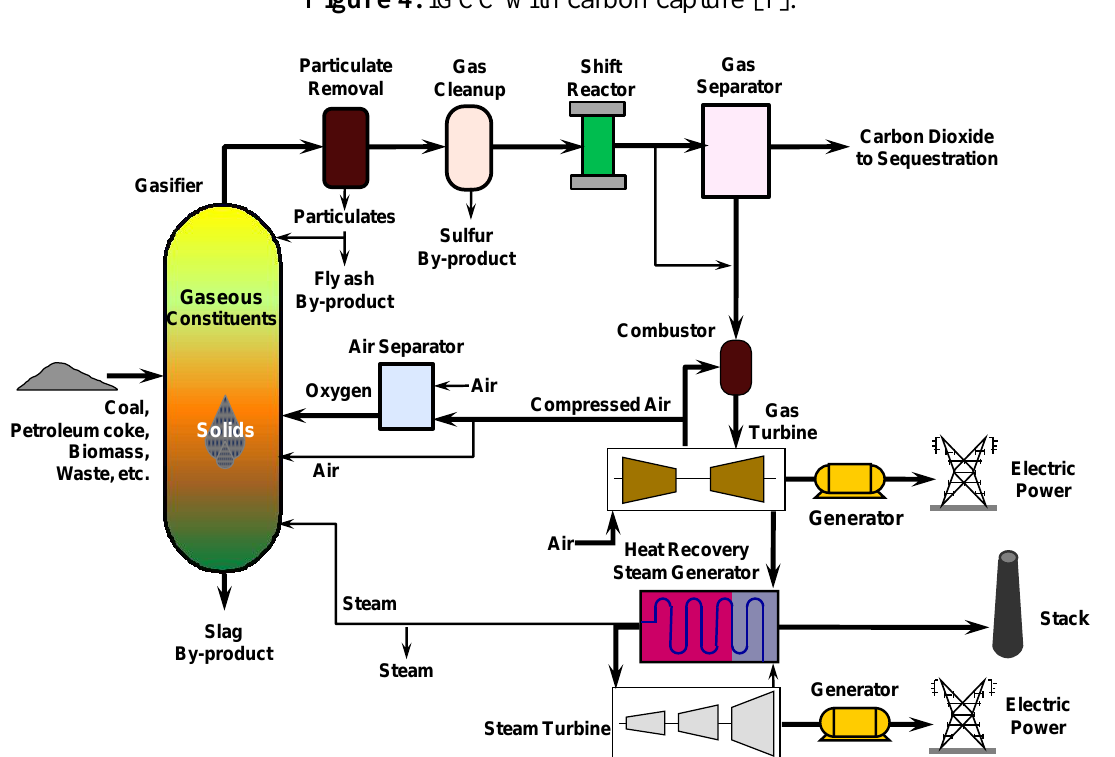
Figure 4. IGCC with carbon capture